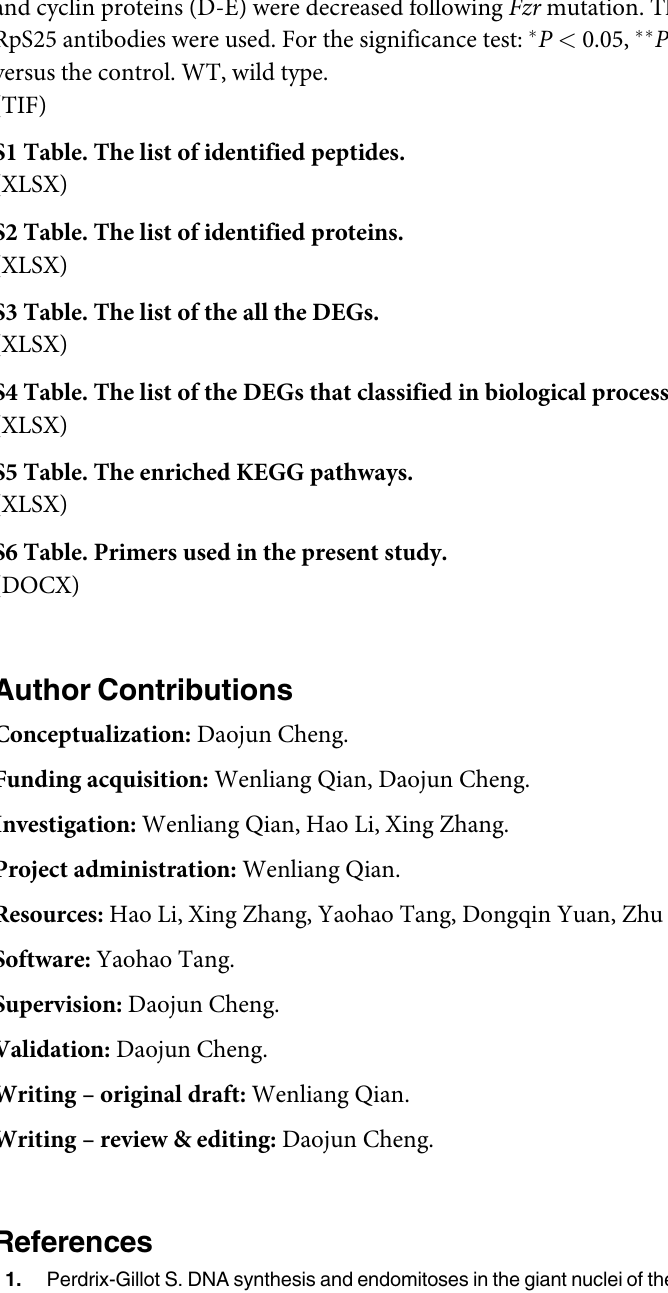
S5 Fig. Clustering analysis and GO annotation of DEPs. ( A ) Hierarchical clustering of all DEPs. Red, proteins with high expression levels; Blue, proteins with low expression levels. ( B ) GO annotation of molecular function class. Size of dots represented numbers of enriched pro- teins; Color of dots represented the GO cluster with a highlighted representative term. S6 Fig. TRAP analysis following RT-qPCR. The translation level of silk protein genes (A-C) and cyclin proteins (D-E) were decreased following Fzr mutation. The anti-RpS15A and anti- RpS25 antibodies were used. For the significance test: � P < 0.05, �� P < 0.01, and ��� P < 0.001 versus the control. WT, wild type. S1 Table. The list of identified peptides. S2 Table. The list of identified proteins. S3 Table. The list of the all the DEGs. S4 Table. The list of the DEGs that classified in biological process and molecular function. S5 Table. The enriched KEGG pathways. S6 Table. Primers used in the present